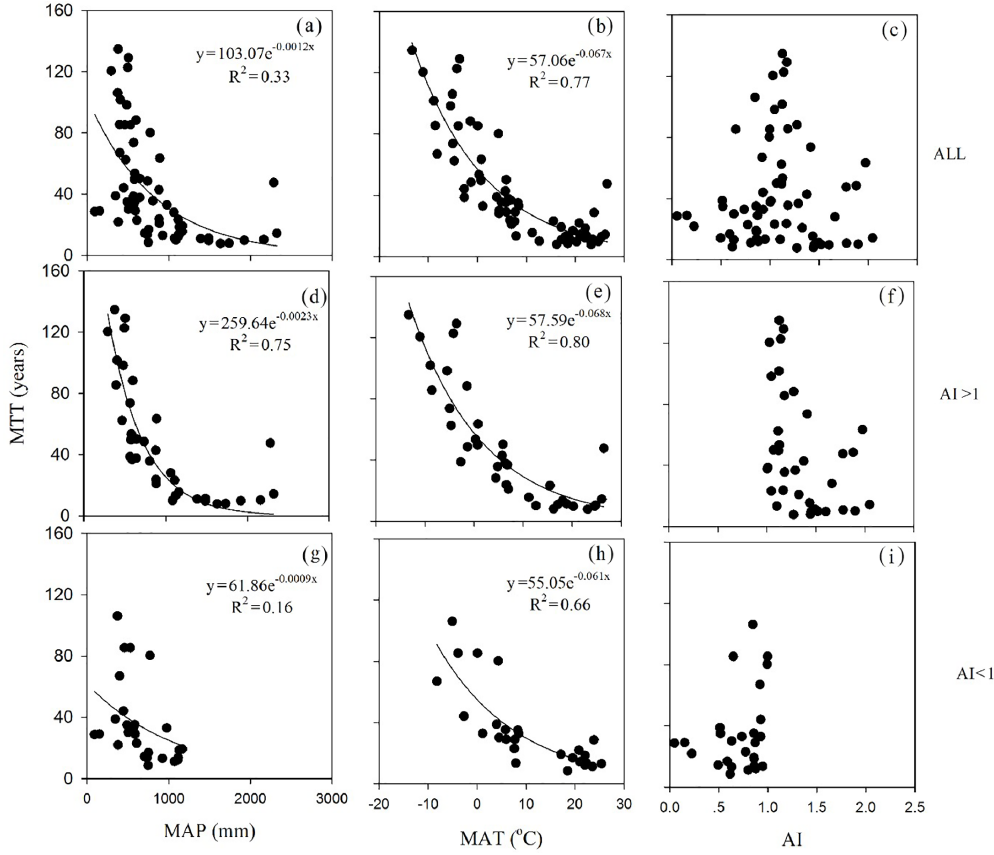
Figure 4. Relationships between ecosystem mean turnover time (MTT) and multi-annual temperature (MAT, b, e, h ) or precipitation (MAP, a, d, g ) at different aridity indexes (AI, c, f, i ). Each data point stands for average values of each biome. Biomes were assigned into 62 types according to land cover and three temperature